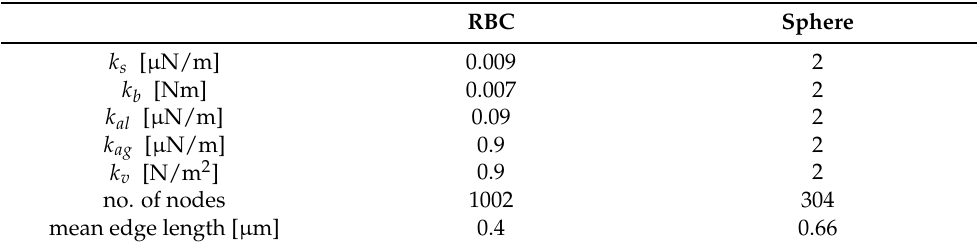
Table A2. Simulation parameters, elastic parameters of RBC in Sections 6.1 and 6.2 and sphere in Section 5.2.2.